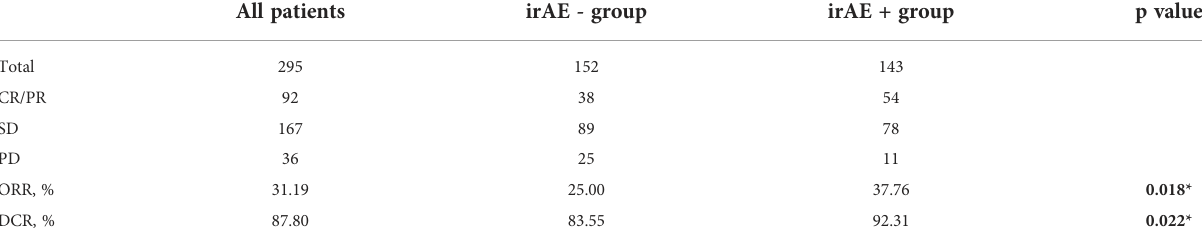
TABLE 2 Best overall response during PD-1